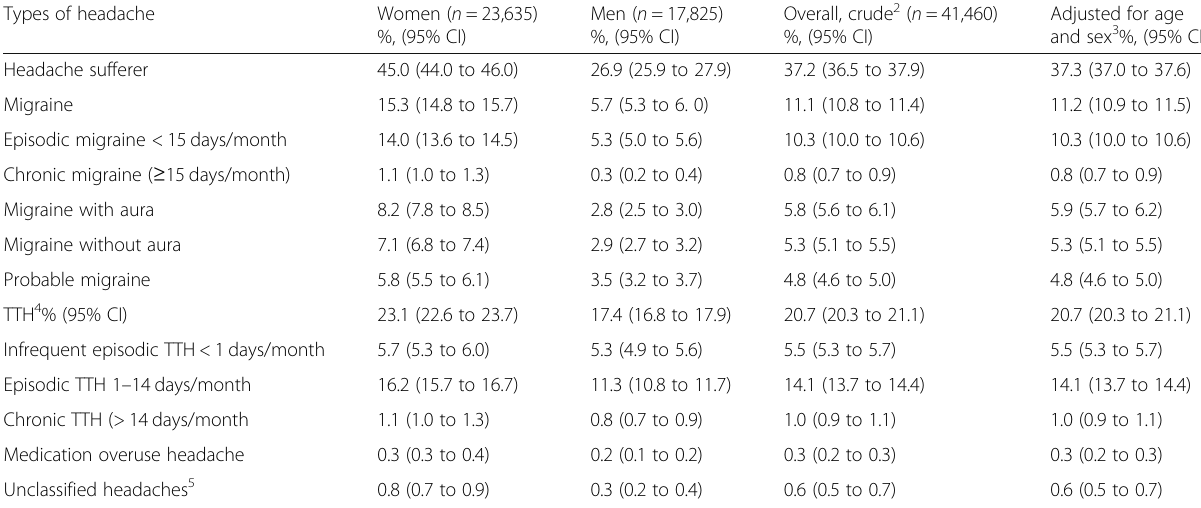
Table 1 One-year prevalence of different headache types 1 in